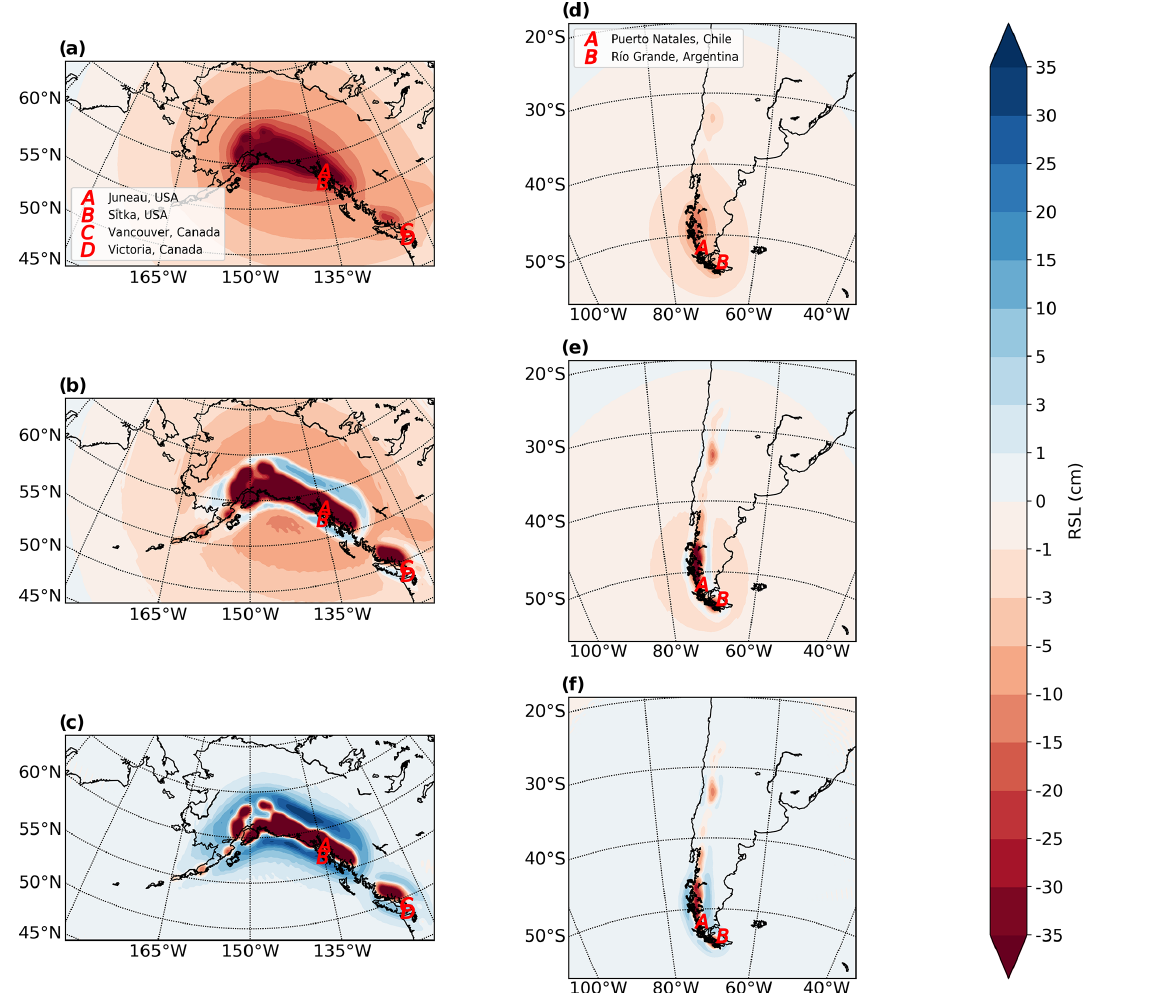
Figure 4. Calculated sea-level fingerprints for estimated changes in regional glacier distributions for RGI regions 1 and 2 (left) and region 17 (right). The different frames show results for (a,d) a 1D (spherically symmetric) elastic Earth model and (b,e) a 3D viscoelastic Earth model with low-viscosity regions located as indicated in Fig. 2. The results in (c) and (f) show the differences between the viscoelastic and elastic results, respectively (i.e. b minus a and e minus d ). Note that these results do not include the sea-level signal associated with ice mass changes from outside of the RGI regions shown. The locations of population centres for which relative sea-level curves are calculated (see Figs. 5 and 6) are indicated by the red